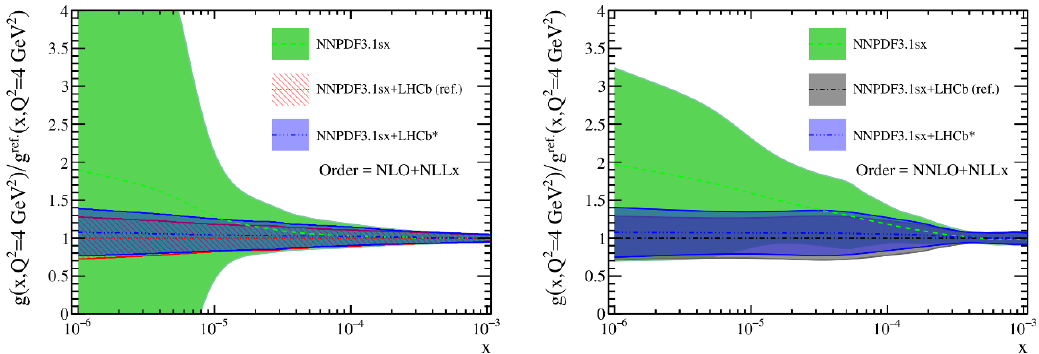
Figure 9 . The same comparison as in the upper plots in (cid:12)gure 8, now normalised to the central value of the NNPDF3.1sx+LHCb baseline result and adding the results (indicated by a * ) of the (cid:12)ts obtained using the modi(cid:12)ed de(cid:12)nition for the (cid:31) 2 in eq. (3.2).